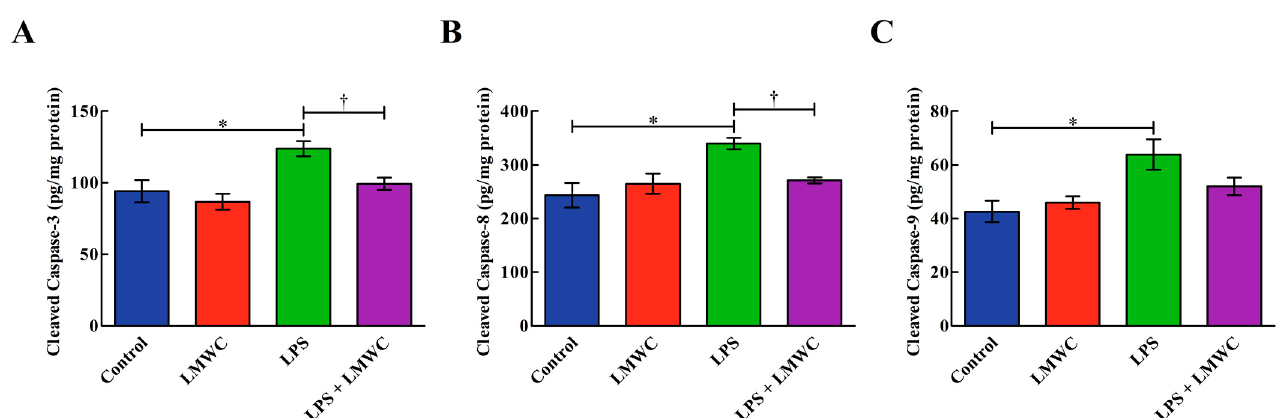
Figure 5. Effects of LMWC on apoptosis in LPS-treated IPEC-J2 cells. ( A ) Early-stage apoptotic cells. ( B ) Late-stage apop- totic cells. ( C ) Total apoptotic cells. Cells were pretreated with LMWC (400 μ g/mL) for 2 h, followed by cotreatment with LPS (5 μ g/mL) for another 6 h. Data are presented as the mean ± standard error ( n = 4). * Means significant difference compared with the control group ( p < 0.05). † Means significant difference compared with the LPS group ( p < 0.05).